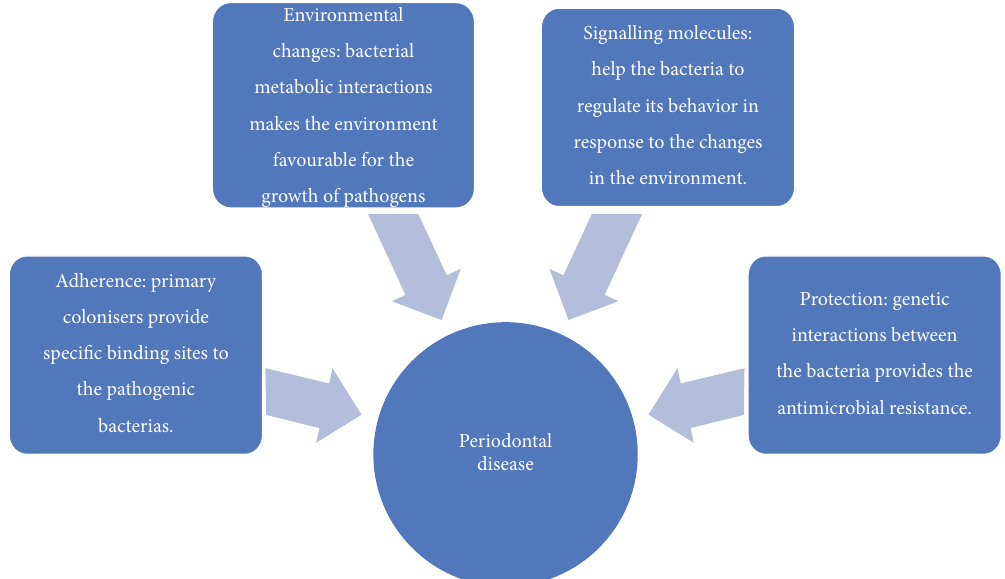
Figure 4: Showing the relation between the interspecies communication and the periodontal disease.